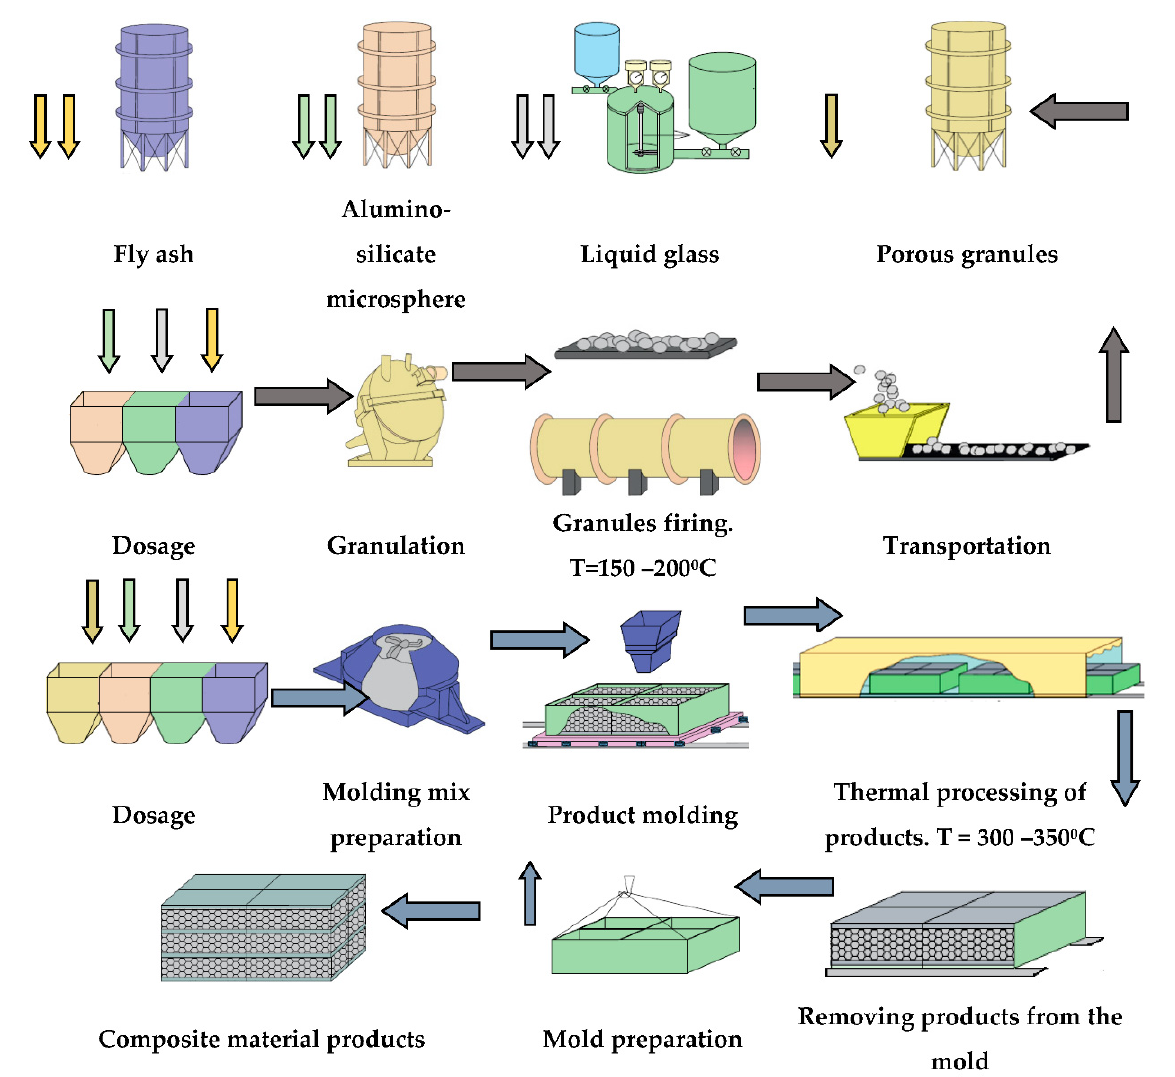
Figure 15. Principal technological scheme of joint production of porous granules and composite material from liquid glass mixtures. material from liquid glass